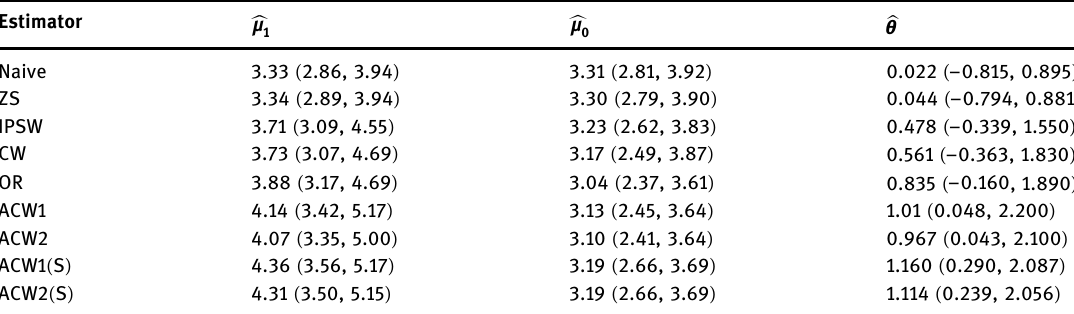
Table 4: Estimates and 95% con fi dence intervals of 12 - year di ff erence of the restricted mean lifetime between adjuvant chemotherapy and